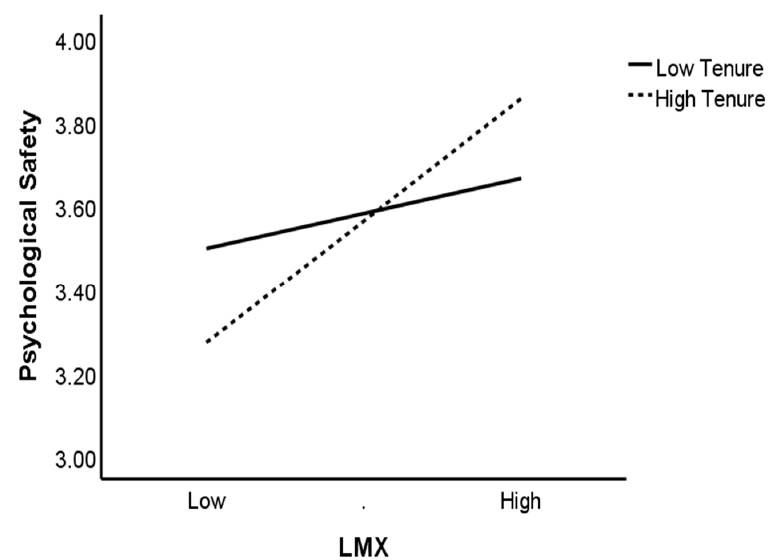
Figure 3. The moderating effect of tenure on the relationship between LMX and psychological safety.